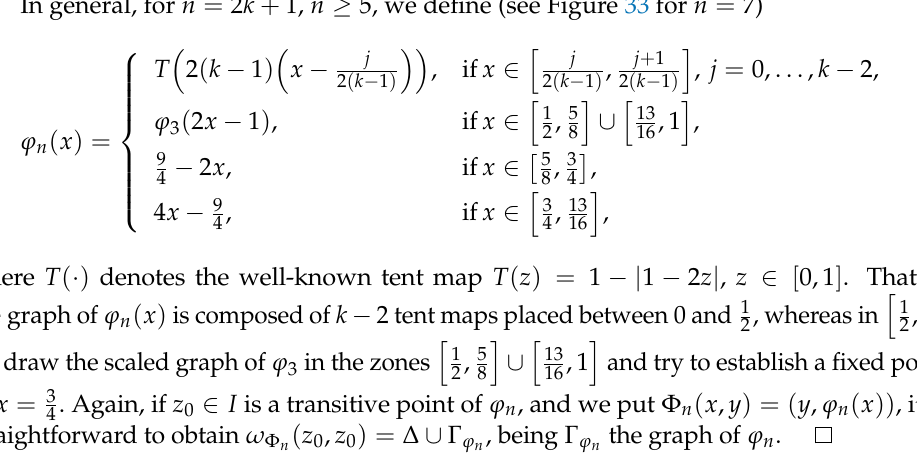
(( w )) homeomorphic to C 0 , w 0 3